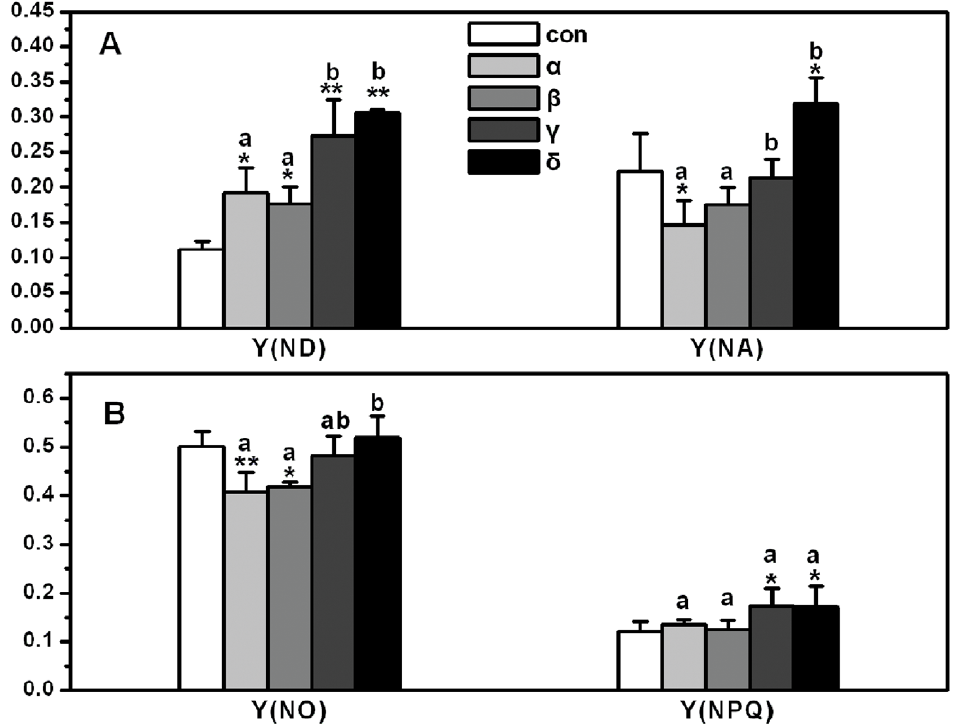
Figure 5. The quantum yields of non-photochemical energy dissipations in PSI and PSII of Arabidopsisthaliana treated by HCH isomers. (A), Y (ND) and Y (NA); (B), Y (NPQ) and Y (NO). Different letters above the columns of HCH isomer treatments show statistically significant differences between them ( p =0.05).